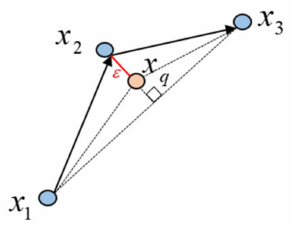
Figure 11. The path optimization